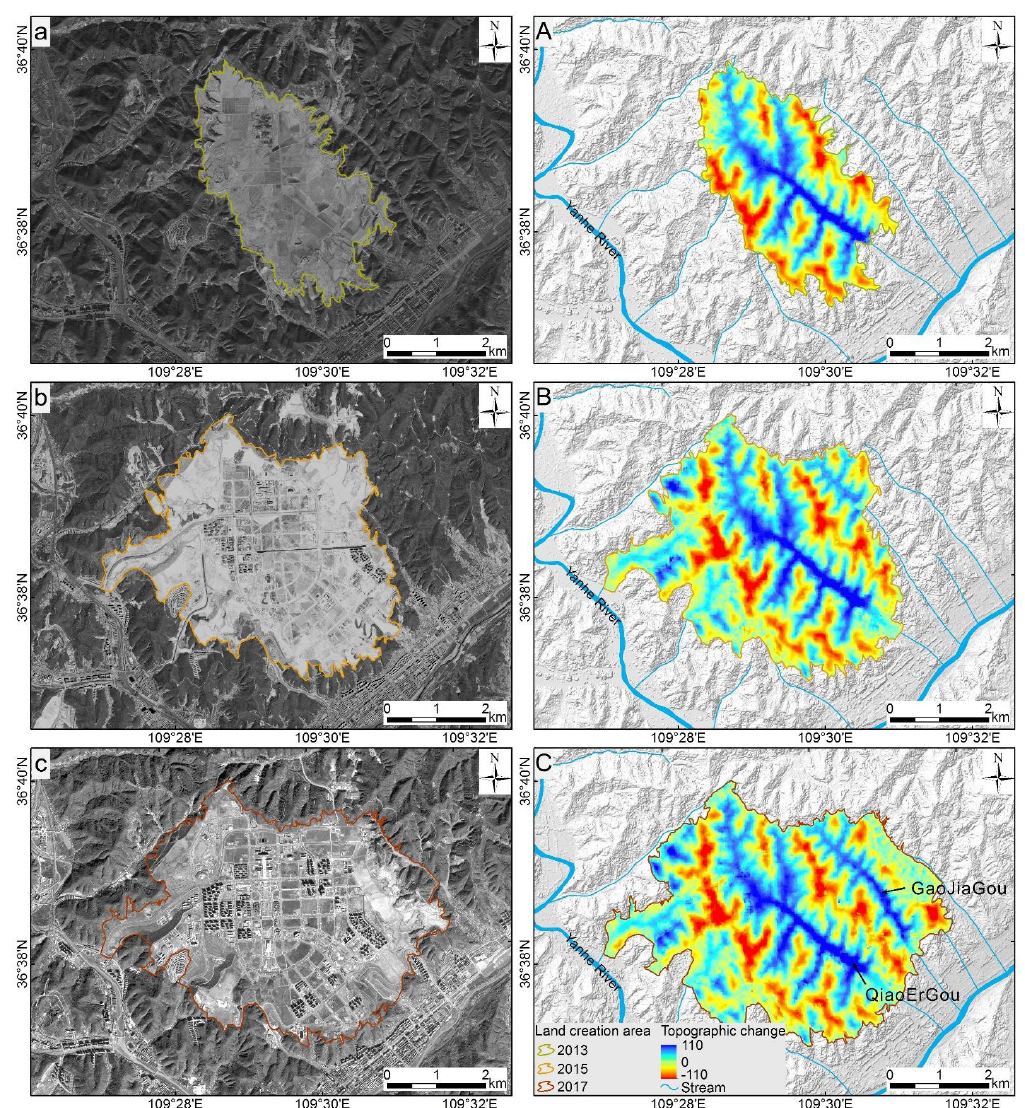
Figure 4. Spatial evolution of the land creation and the corresponding topographic changes in the YND. ( a – c ) History of the land creation revealed by the ZY-3 panchromatic images; ( A – C ) topographic changes in 2000–2013, 2000–2015 and 2000–2017 estimated by calculating the difference between the SRTM and the ZY-3 DEMs. Table 2. The fill thicknesses for the two main valley-filling areas.